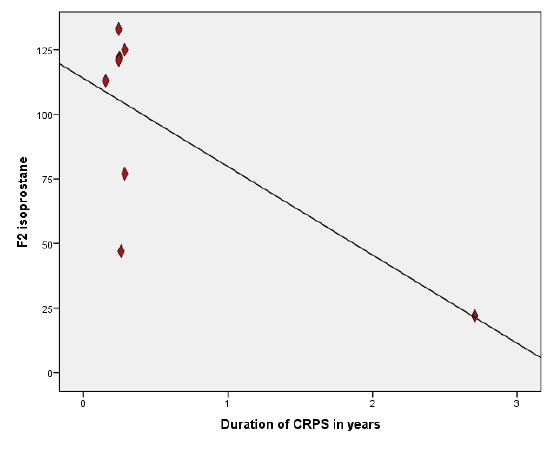
Figure 1. Correlation between levels F2 isoprostane and duration of CRPS. R = − 0.72; ( p =